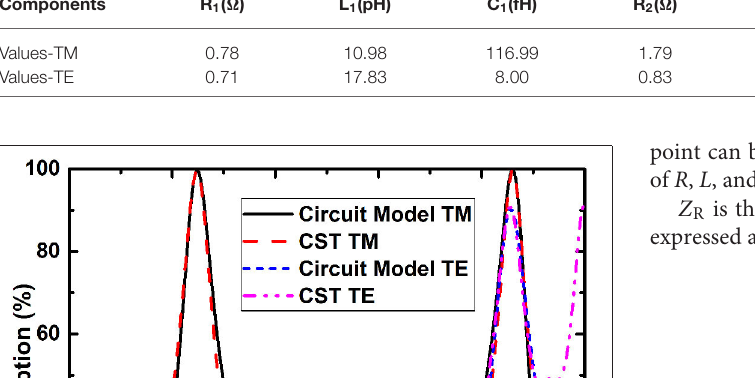
TABLE 2 | Optimum circuit parameters based on the equivalent circuit model. Components